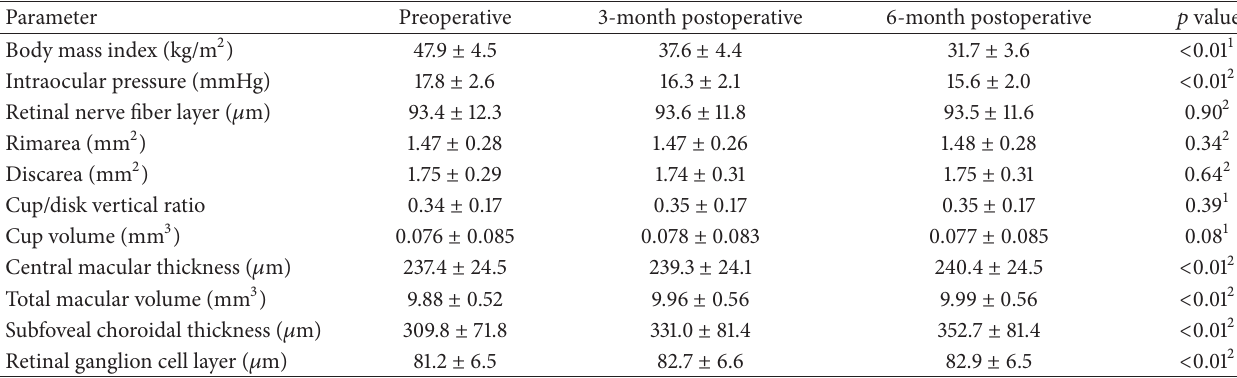
Table 1: Preoperative and 3-month and 6-month postoperative values.